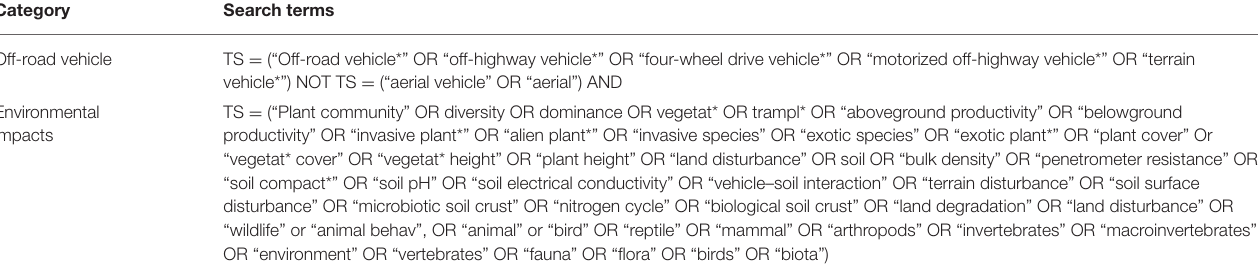
TABLE 1 | Combination of search terms used in Web of Science literature search.